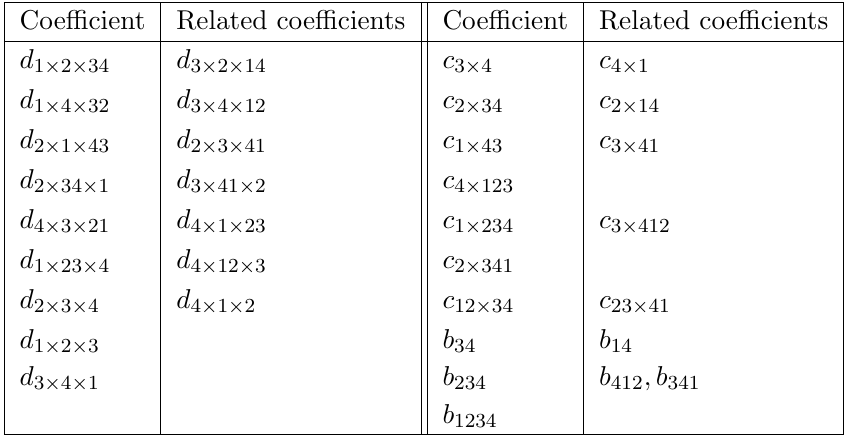
2 + 3 + 4 (cid:0) g g g g